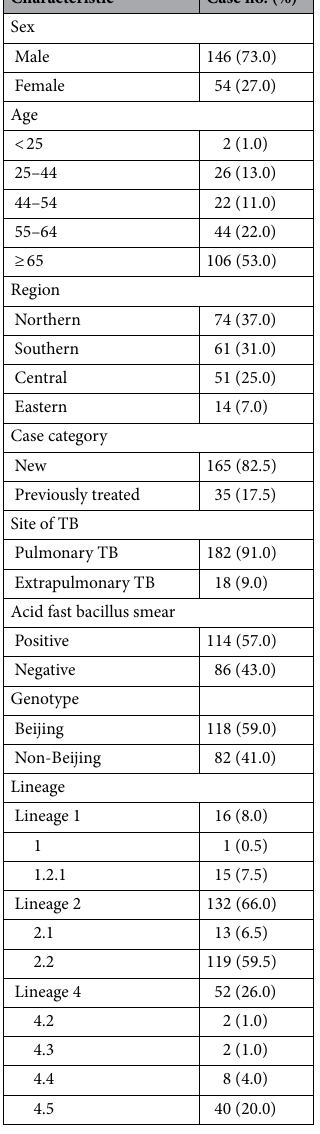
Table 1. Demographics and characteristics of the 200 study